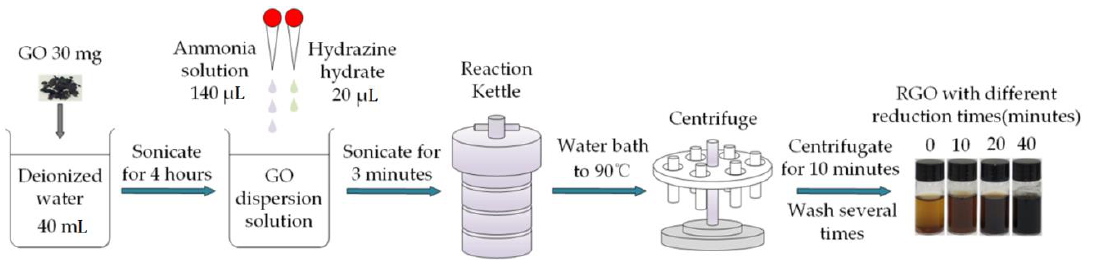
Figure 1. Synthesis flowchart of RGO with four different reduction times.